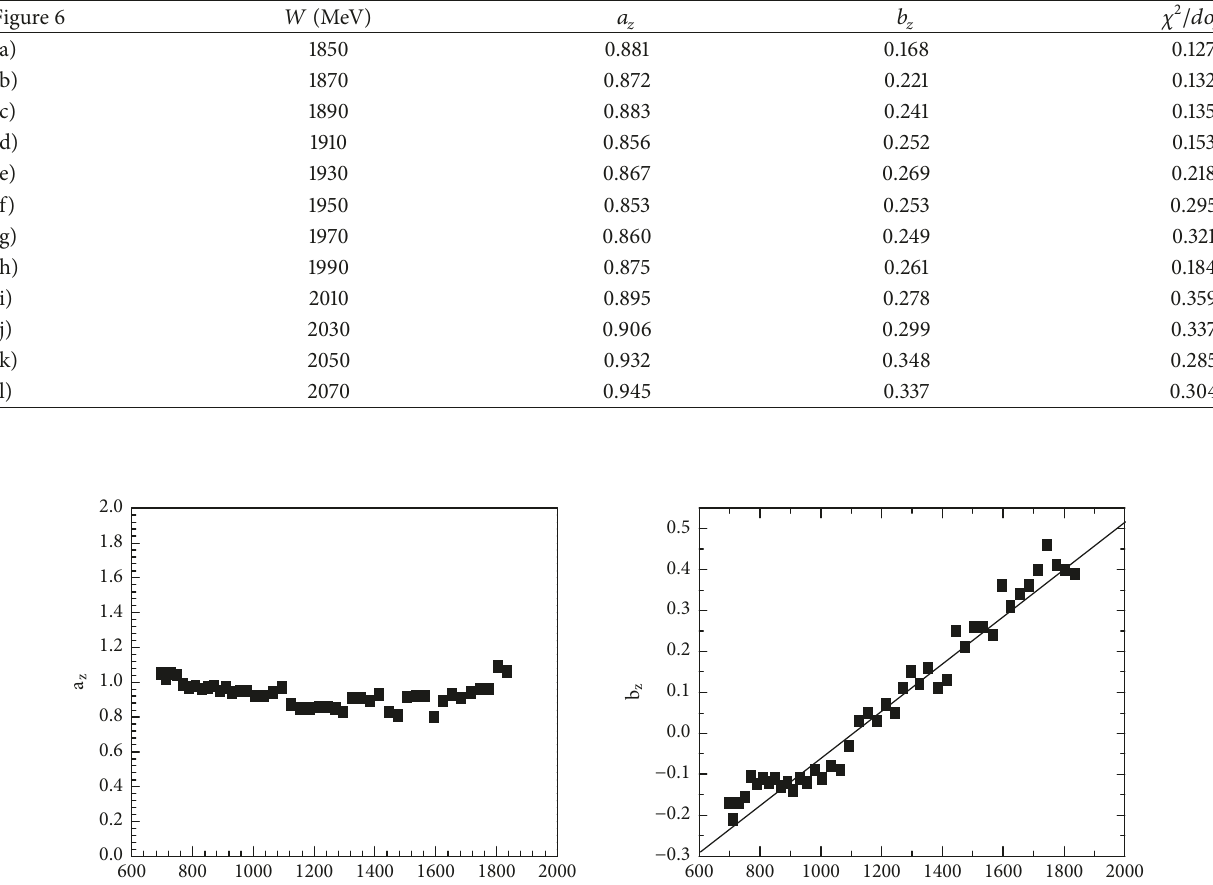
Table 6: Values of 𝑎 𝑧 and 𝑏 𝑧 taken in Figure 6 model results.